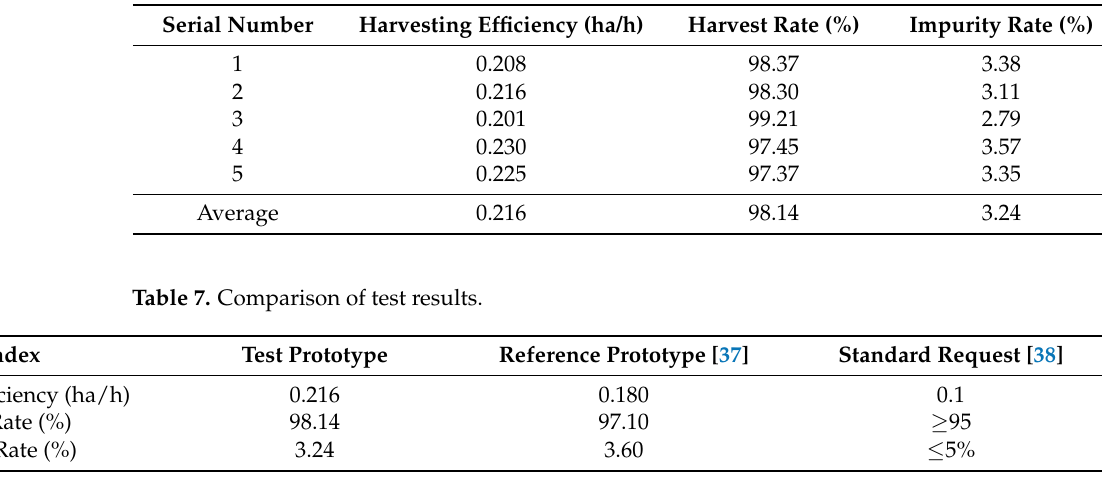
Table 6. Field test results.